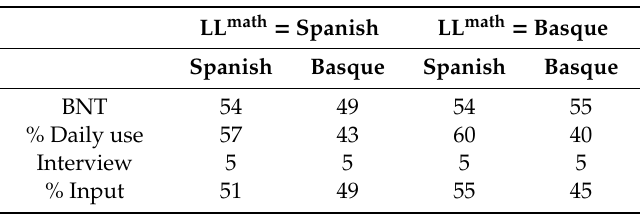
Table 1. Scores in the di ff erent language tests (Experiment 1) for both: Boston Naming Test (BNT): Interview: Mean score in the interview session, scores ranged from one to five. % Input refers to the average amount of time exposed to each language (reading, writing, speaking and listening) by the participants in each